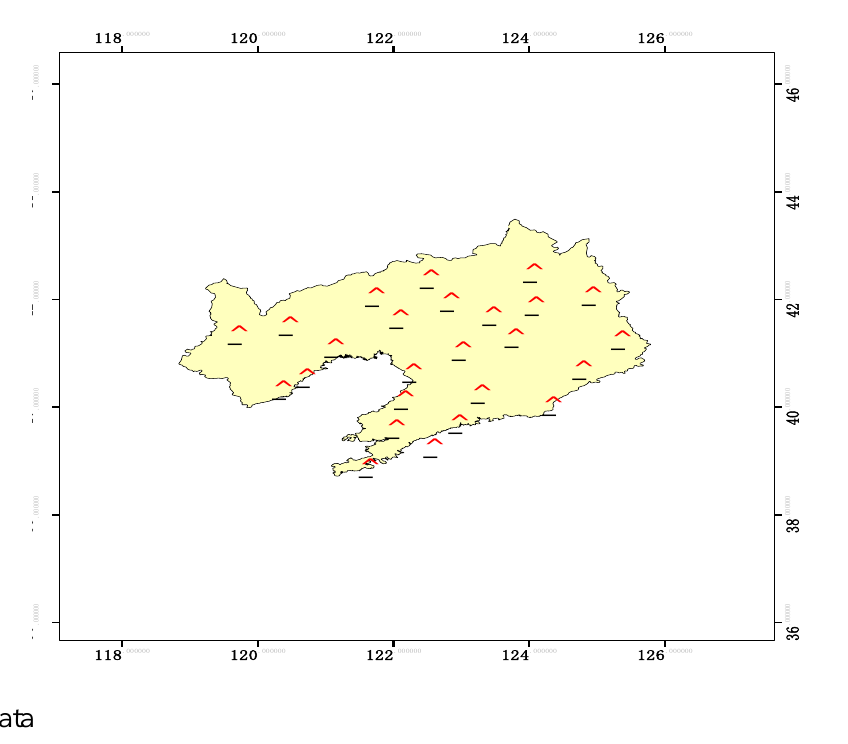
Figure 2. Distribution of the 25 weather stations used for the study